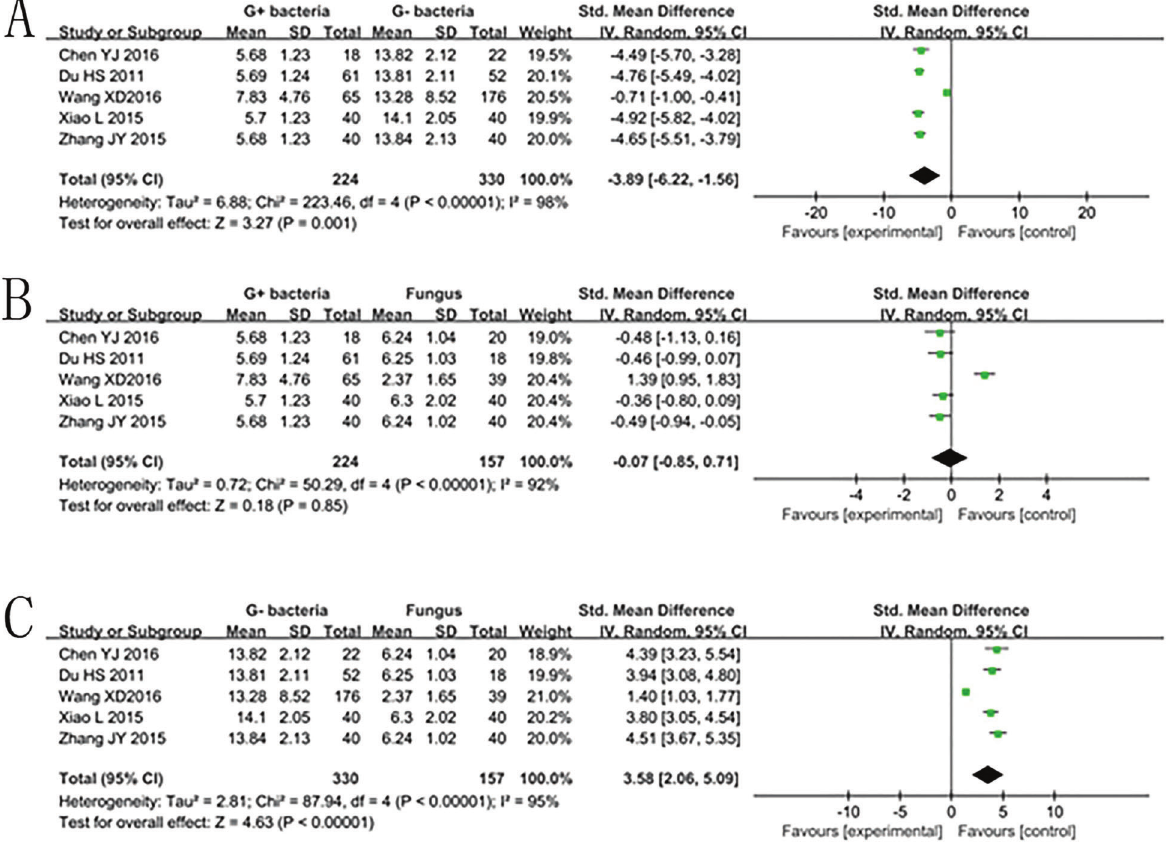
Figure 4. Forest plot for the concentration of procalcitonin (PCT) between A ) G + bacterial infection and G – bacterial infection group, B ) G + bacterial infection and fungus infection group, and C ) G – bacterial infection and fungus infection